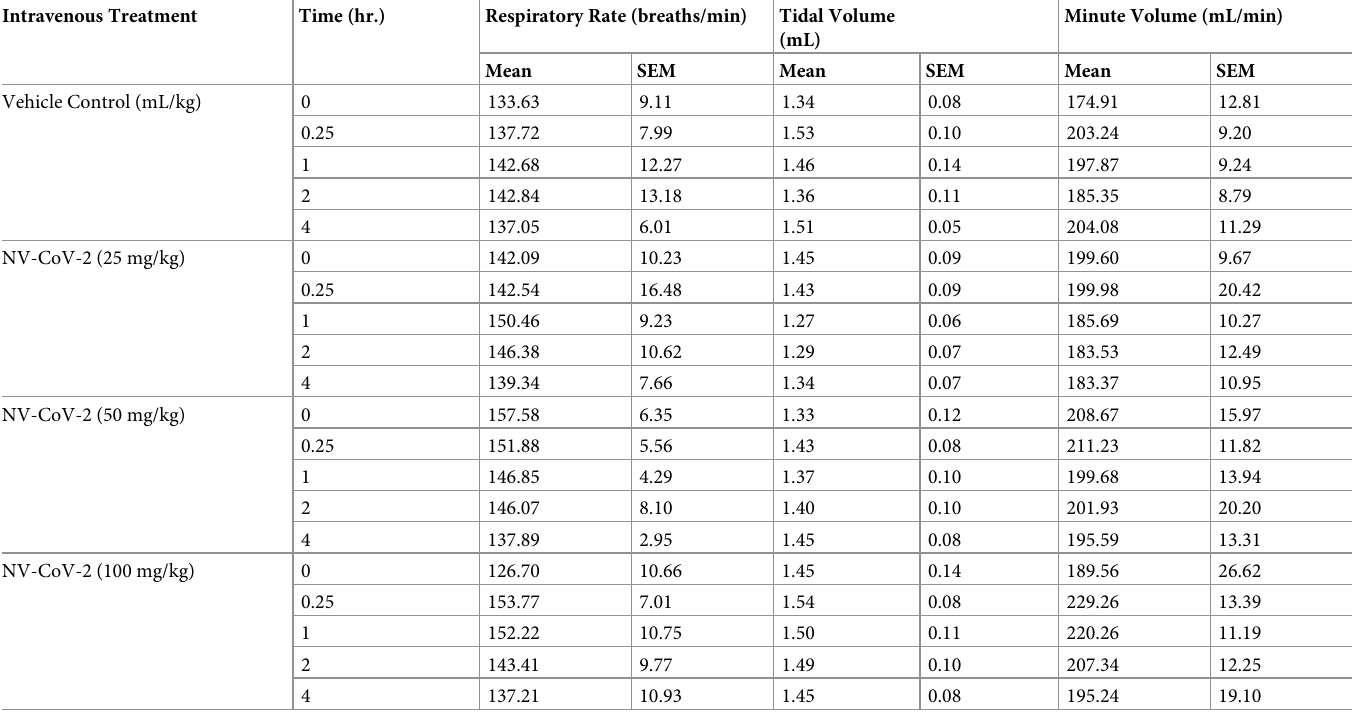
Table 5. Effects of the vehicle and NV-CoV-2 on pulmonary parameters.